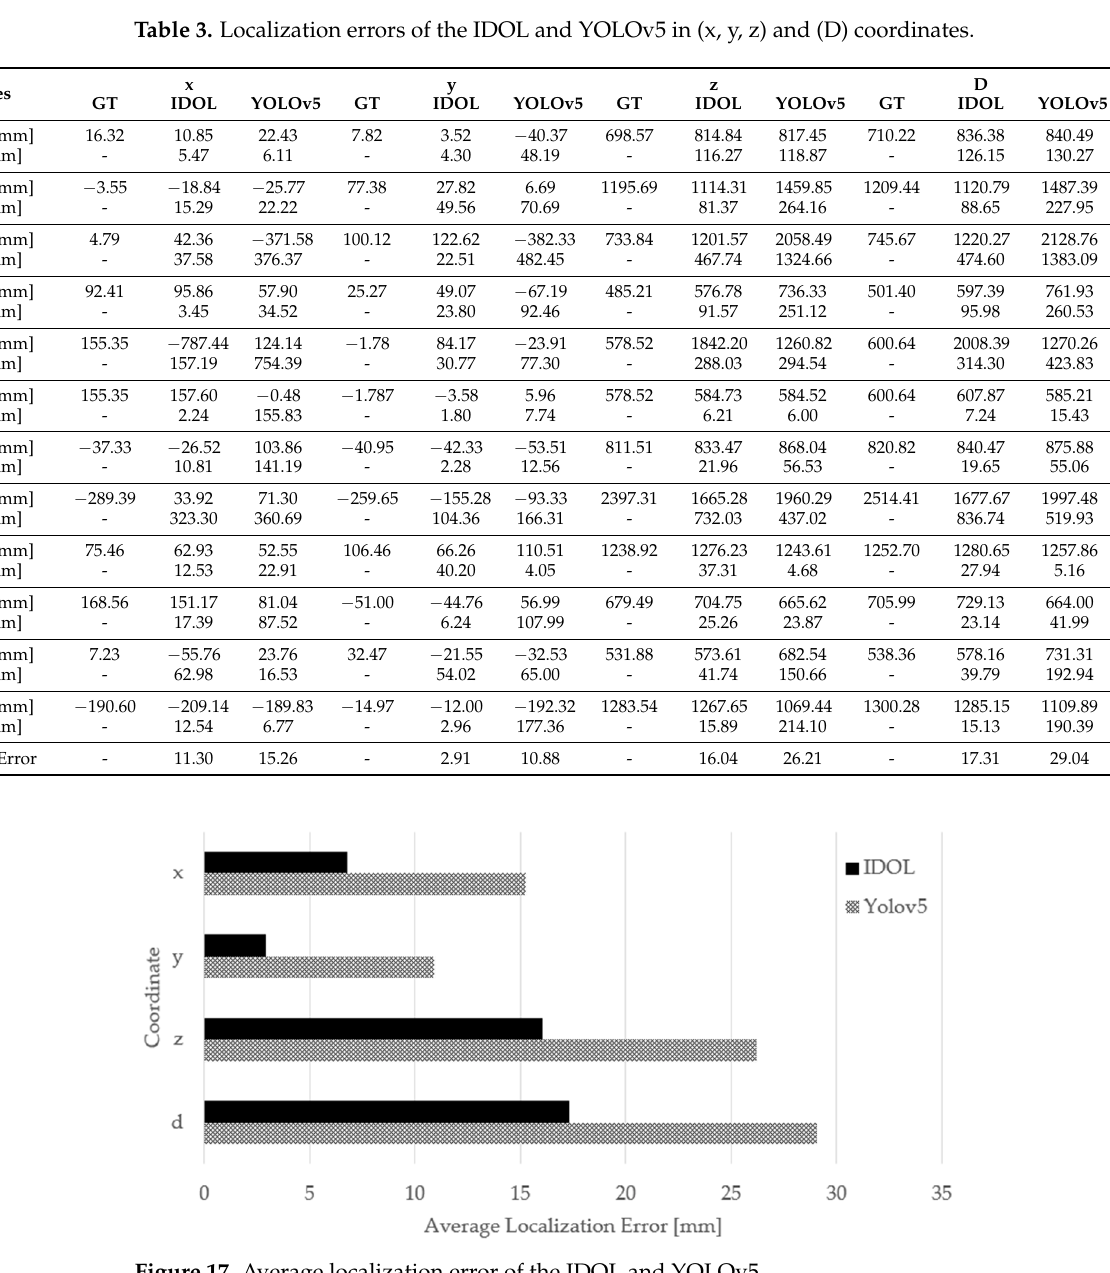
Figure 17. Average localization error of the IDOL and YOLOv5. The results indicate that the IDOL algorithm displays superior object localization per- formance compared to the YOLOv5 object detection model, resulting in a closer approxi- mation to the ground truth coordinates. The average localization error of the 3D point cloud coordinates (x, y, z, D) of the IDOL algorithm was found to be less than 18 mm. These findings suggest that the object localization of the IDOL algorithm is more valid and accurate than that of the YOLOv5 object detection model.